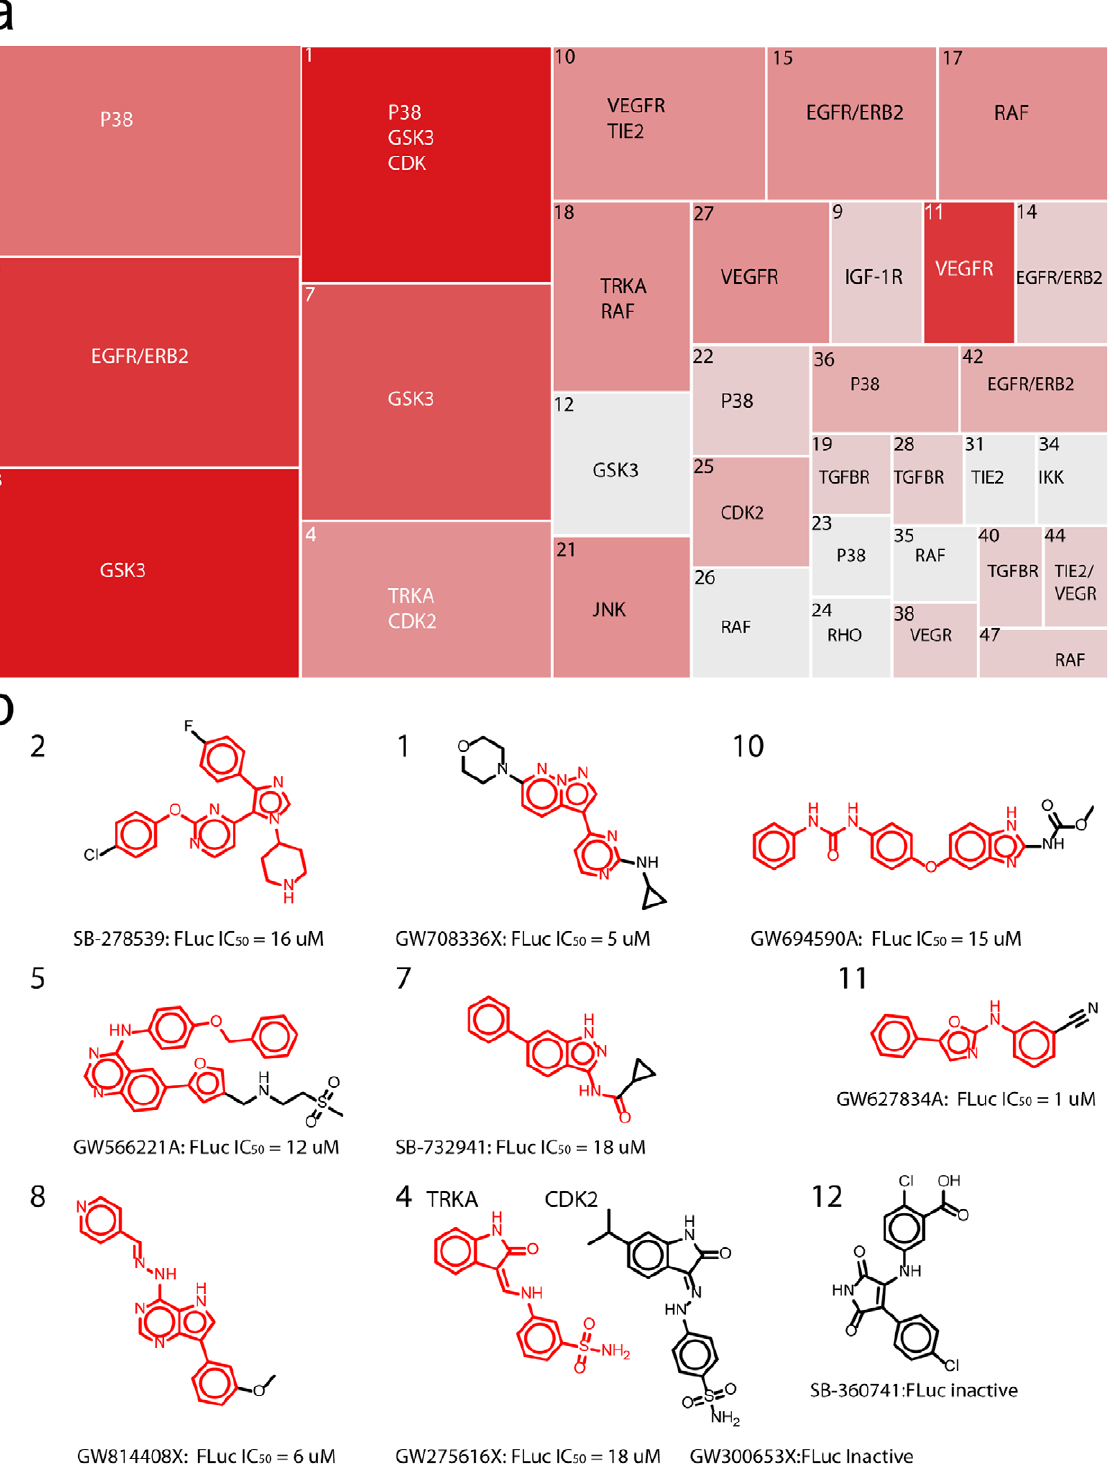
Figure 2. PKIS chemotype clusters with FLuc activity. ( a ) Treemap depicting 47 clusters based on Tanimoto similarity coefficients of 0.75. The size of each box represents the ratio of active to inactive compounds while the color represents the number of high quality (class 1 and 2) curves. The boxes, numbered by cluster are additionally annotated by the original target(s) associated with the cluster. Not shown are singletons or clusters where no FLuc inhibitors were identified. ( b ) Representative structures and FLuc potency values associated with prominent boxes on the treemap.